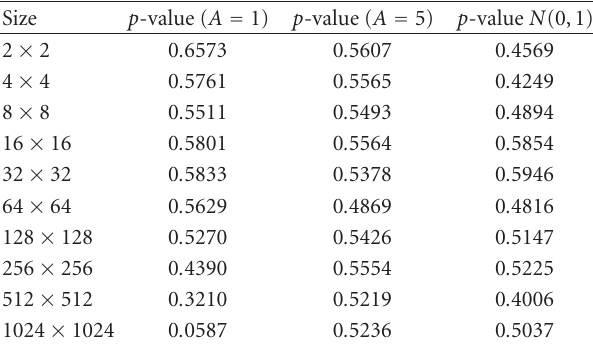
Table 2: p -values produced by the KS test for the di ff erence be- tween images with Rician distributed noise with signal amplitudes A = 1 and A = 5, and for images of the same size with N (0,1)- noise.